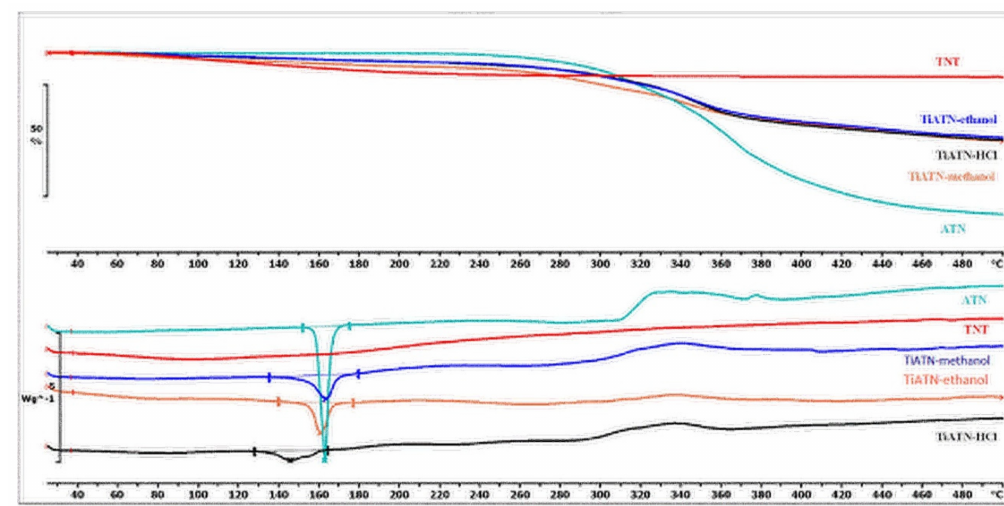
Figure 4. Di ff erential scanning calorimetry (DSC) and thermogravimetric (TG) curves of TNT, ATN, TiATN–methanol, TiATN–ethanol, and TiATN–HCl.